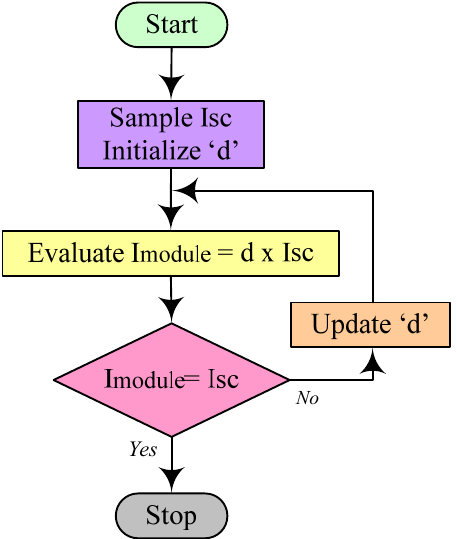
Figure 11. FSCC-based MPPT technique [30].